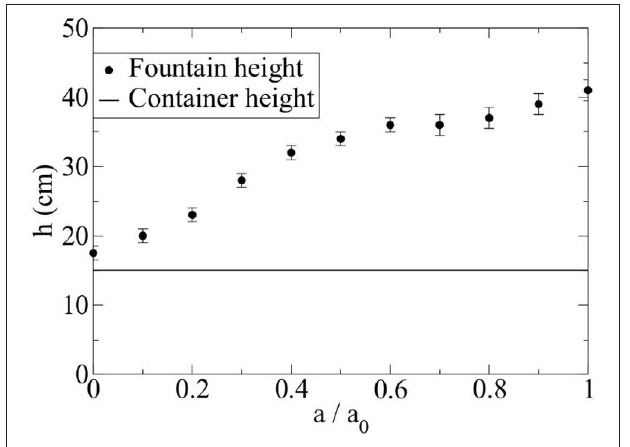
FIGURE 8 | Fountain height h as a function of bottom roughness a when h 1 = 4 m. The container height is the vertical extent of the container and thus a minimum value for h .